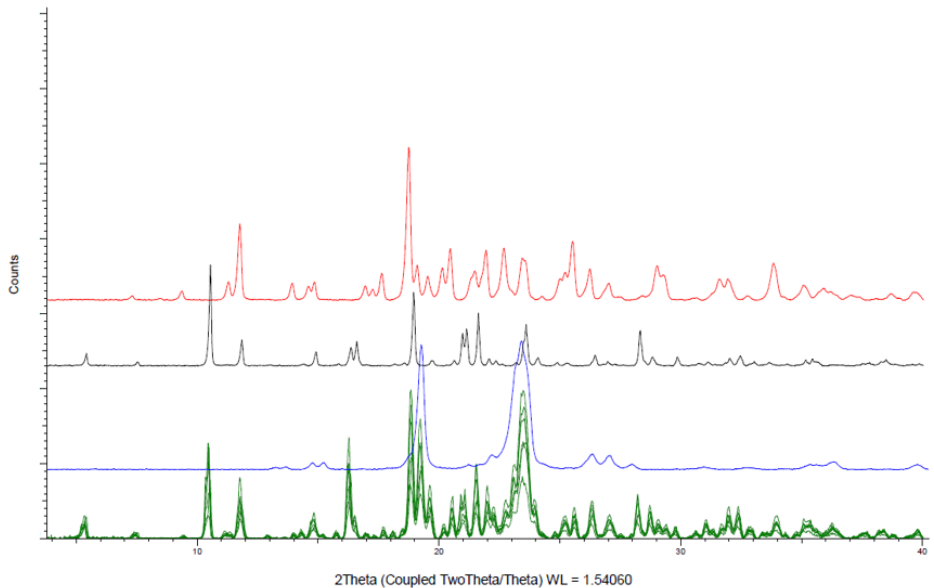
Figure 2. X-ray powder diffraction analysis of amiodarone hydrochloride formulations (green), amiodarone hydrochloride (black), PEO (blue), D -sorbitol (red). In order to compare the thermal decomposition pattern and water absorption of the formulations in the state of powders, thermo-gravimetric analysis was carried out (Figure 3). Samples weight loss was integrated and reported in Table 5, revealing that all formula- tions lost around 1% of their weights after reaching 115 °C, probably due to the evapora- tion of adsorbed water. The degradation started at 160 °C due to amiodarone